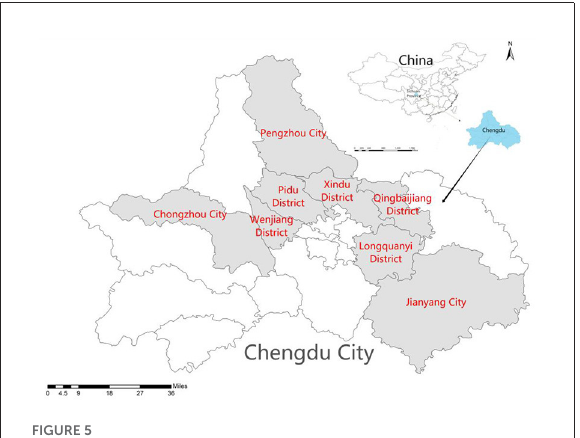
FIGURE5 Distribution map of investigation